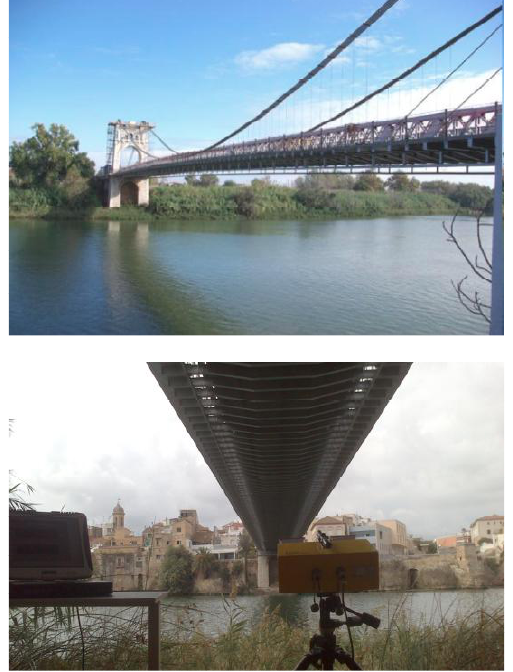
Figure 3. Two views of the monitored bridge and of the measuring RAR system